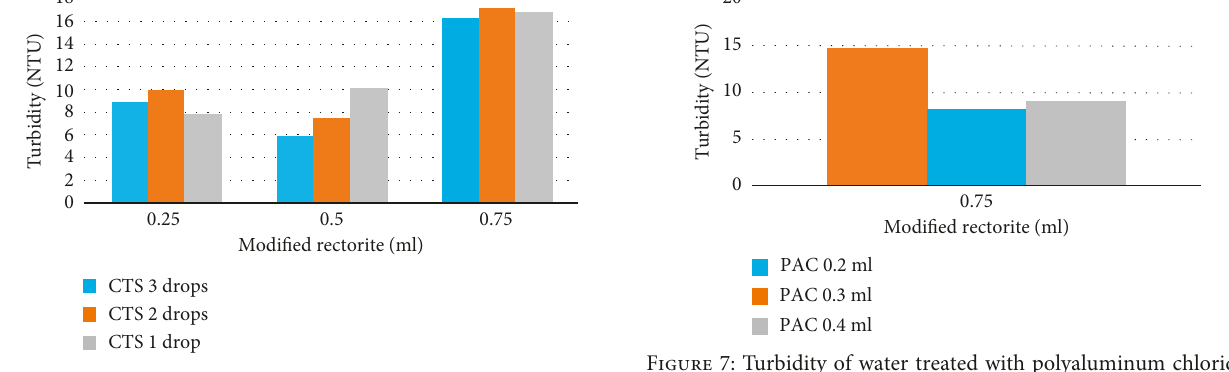
Figure 5: Turbidity of the effluent with chitosan and modified